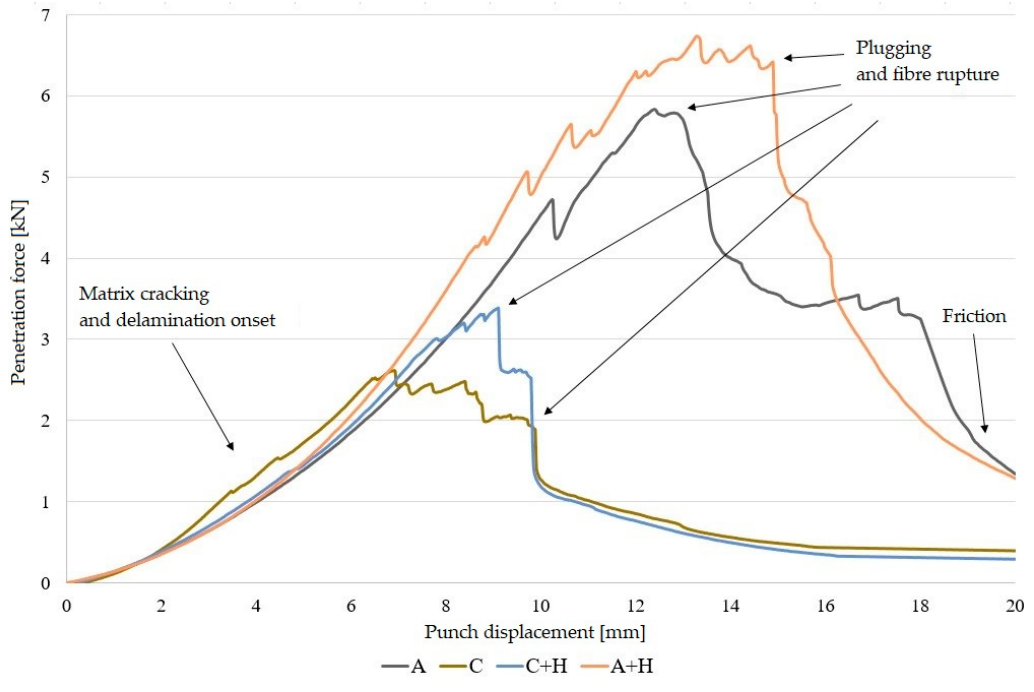
Figure 6. Variation of penetration force curves for non-hybrid laminates (designations as given in Table 2).